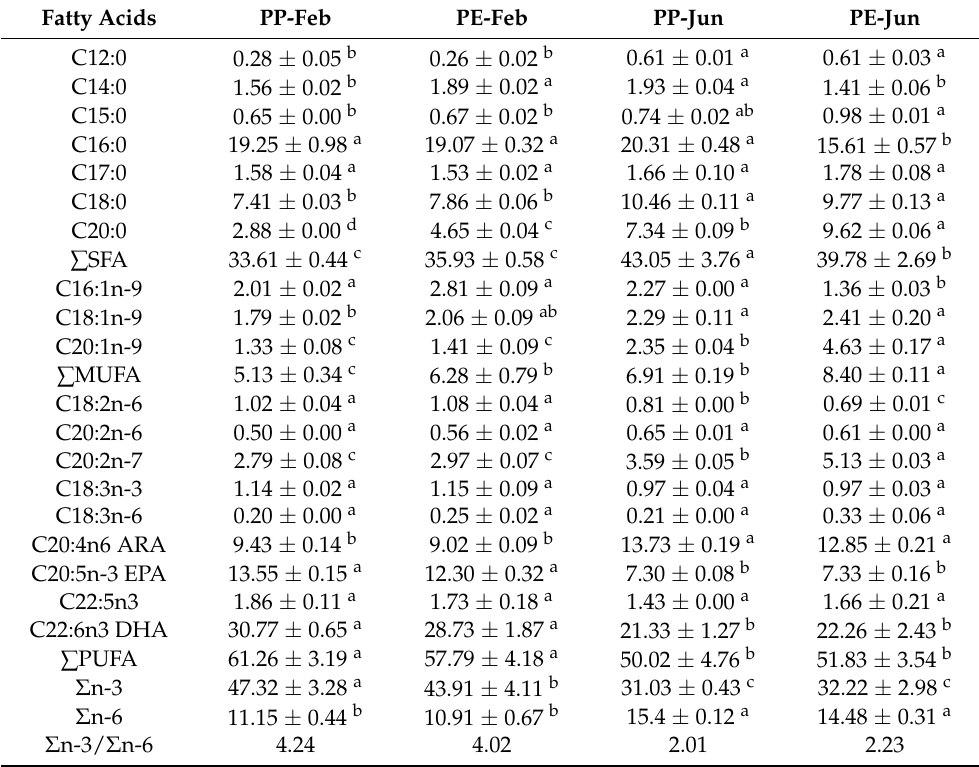
Table 5. Fatty acid profiles of two P. f. martensii selective strains it different seasons (%). Fatty Acids PP-Feb PE-Feb